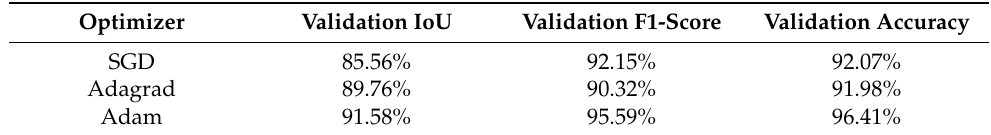
Table 2. Validation metrics using different optimization strategies.